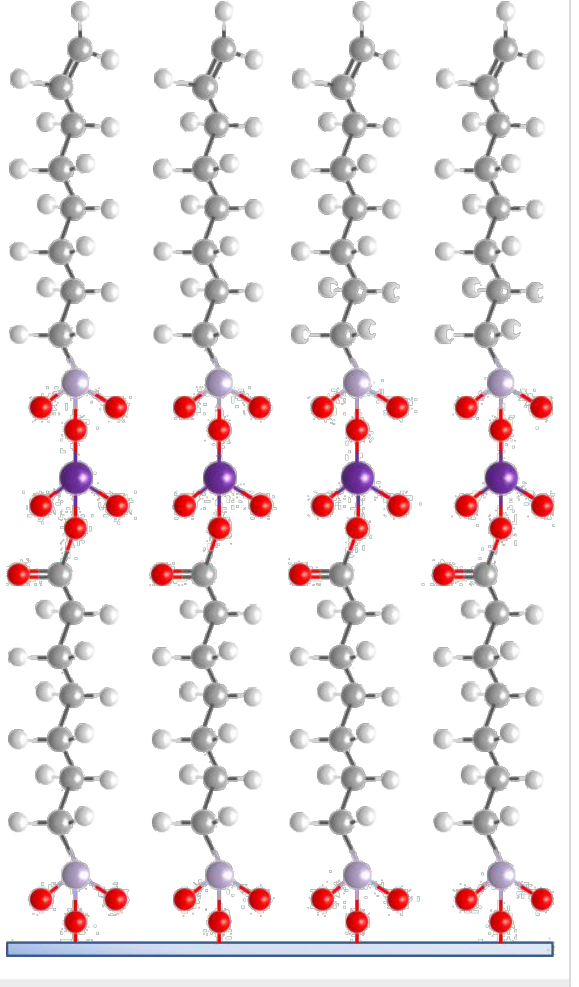
Figure 9: Schematic illustration of an ALD/MLD inorganic–organic hybrid thin film deposited using 7-octenyltrichlorosilane and Ti(OCH(CH 3 ) 2 ) 4